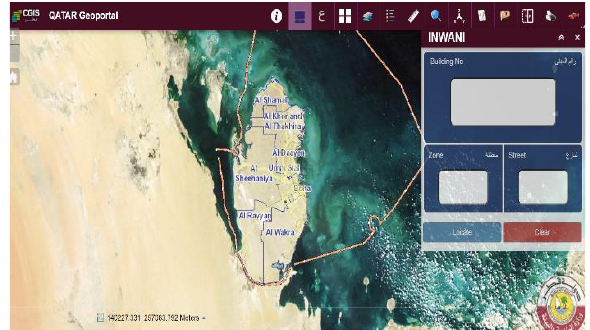
Figure 3 . QATAR Geoportal